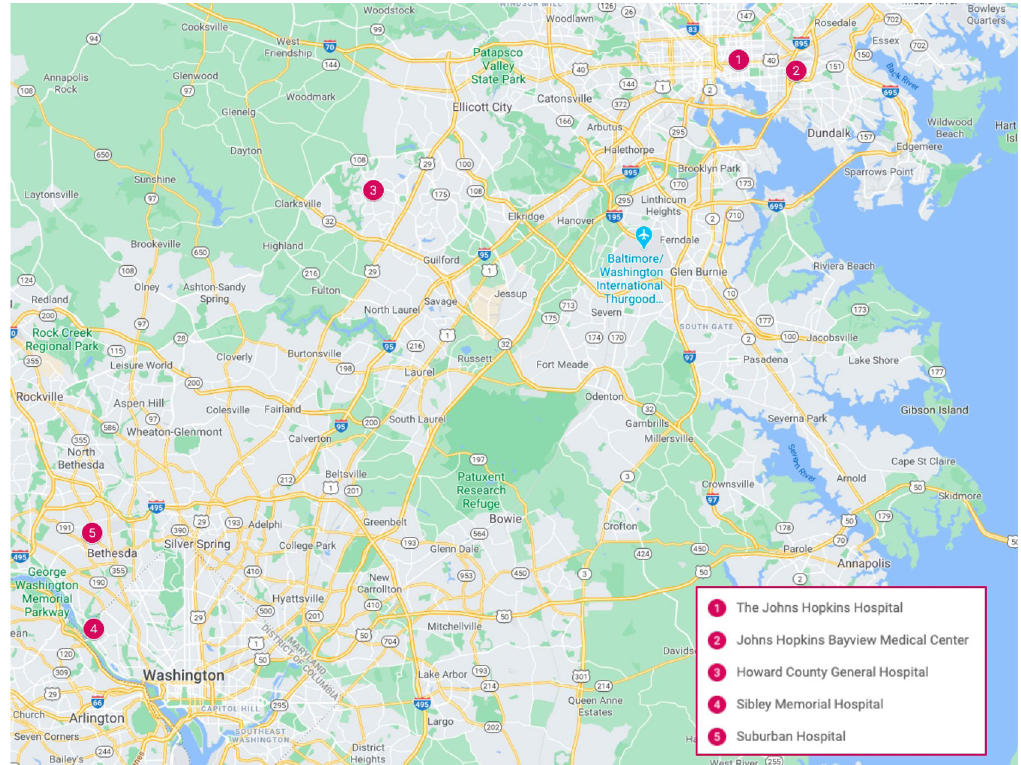
Figure 1. Johns Hopkins Health System (JHHS). Hospital Emergency Departments in Red. Adapted from google map. 16